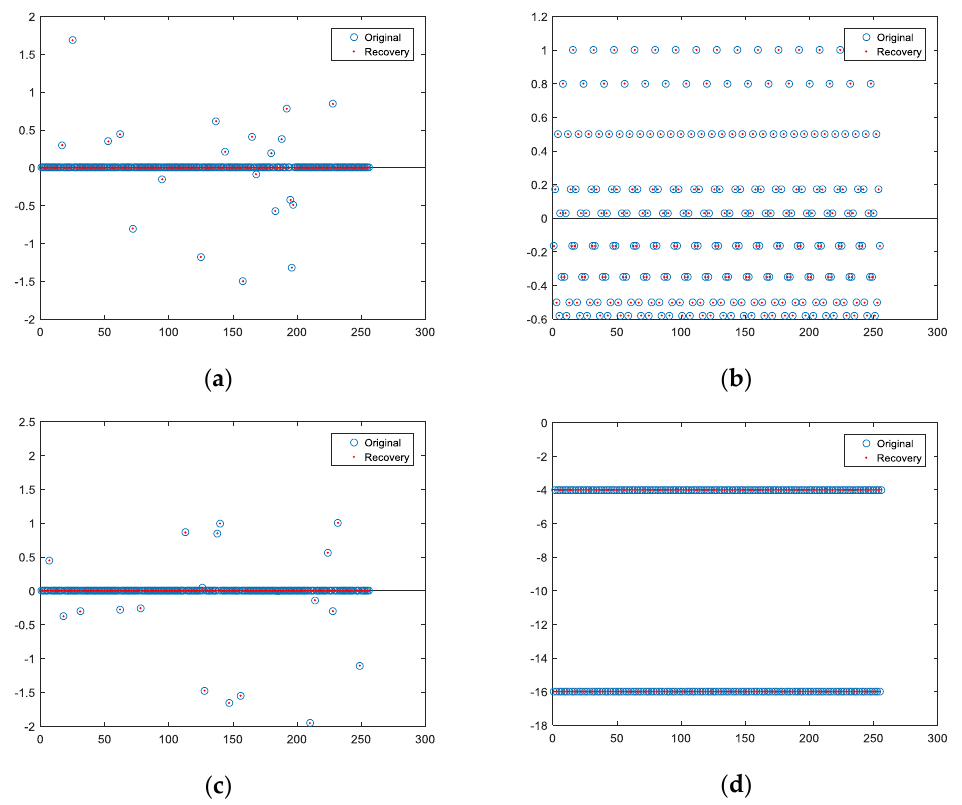
Figure 3. Reconstruction effect diagram for different signals: ( a ) Signal 1; ( b ) Signal 2; ( c ) Signal 3; ( d ) Signal 4.